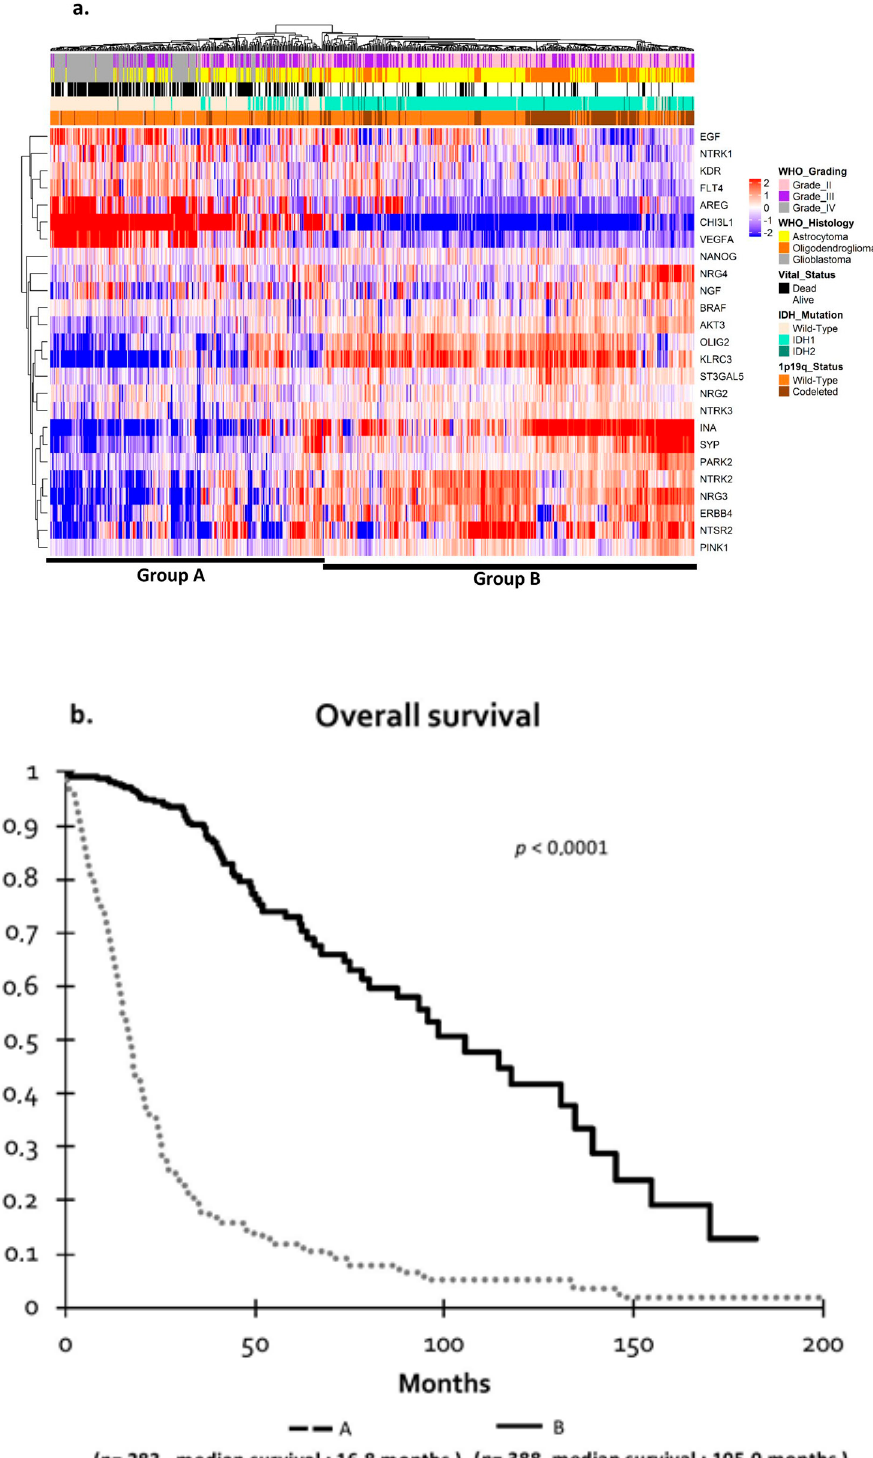
Figure 2. ( a ) Hierarchical clustering of brain tumors based on The Cancer Genome Atlas (TCGA) cohort: Hierarchical clustering of 671 gliomas based on 26 genes. Analysis of TCGA samples was performed as in Figure 1a. ( b ) Overall survival in TCGA cohort by Kaplan–Meier analysis. Survival group A (dotted line) defined unfavorable prognosis, and survival group B (bold line) defined favorable prognosis ( p = 0.007). p -values were calculated using log-rank test.